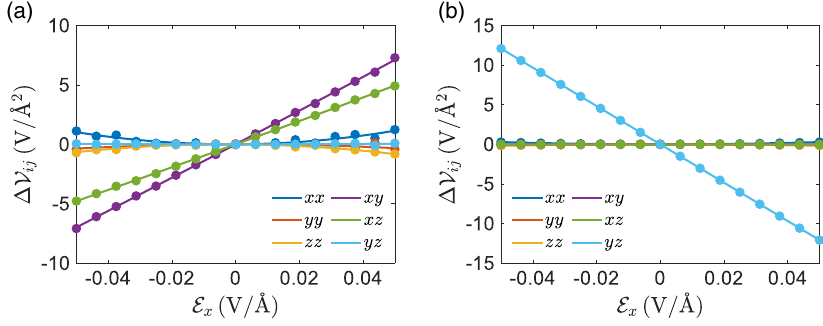
FIG. 6. The EFG V tensor as a function of electric field E